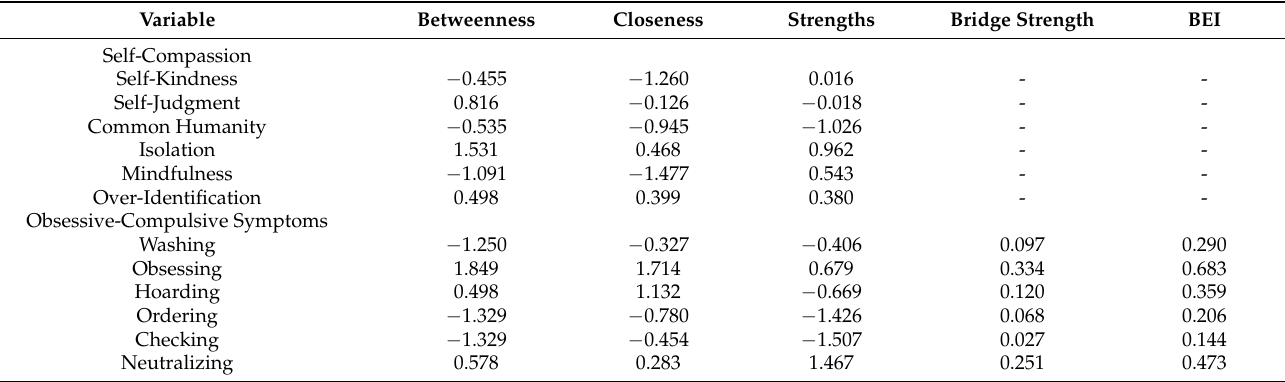
Table 3. Centrality measures of the network analysis.